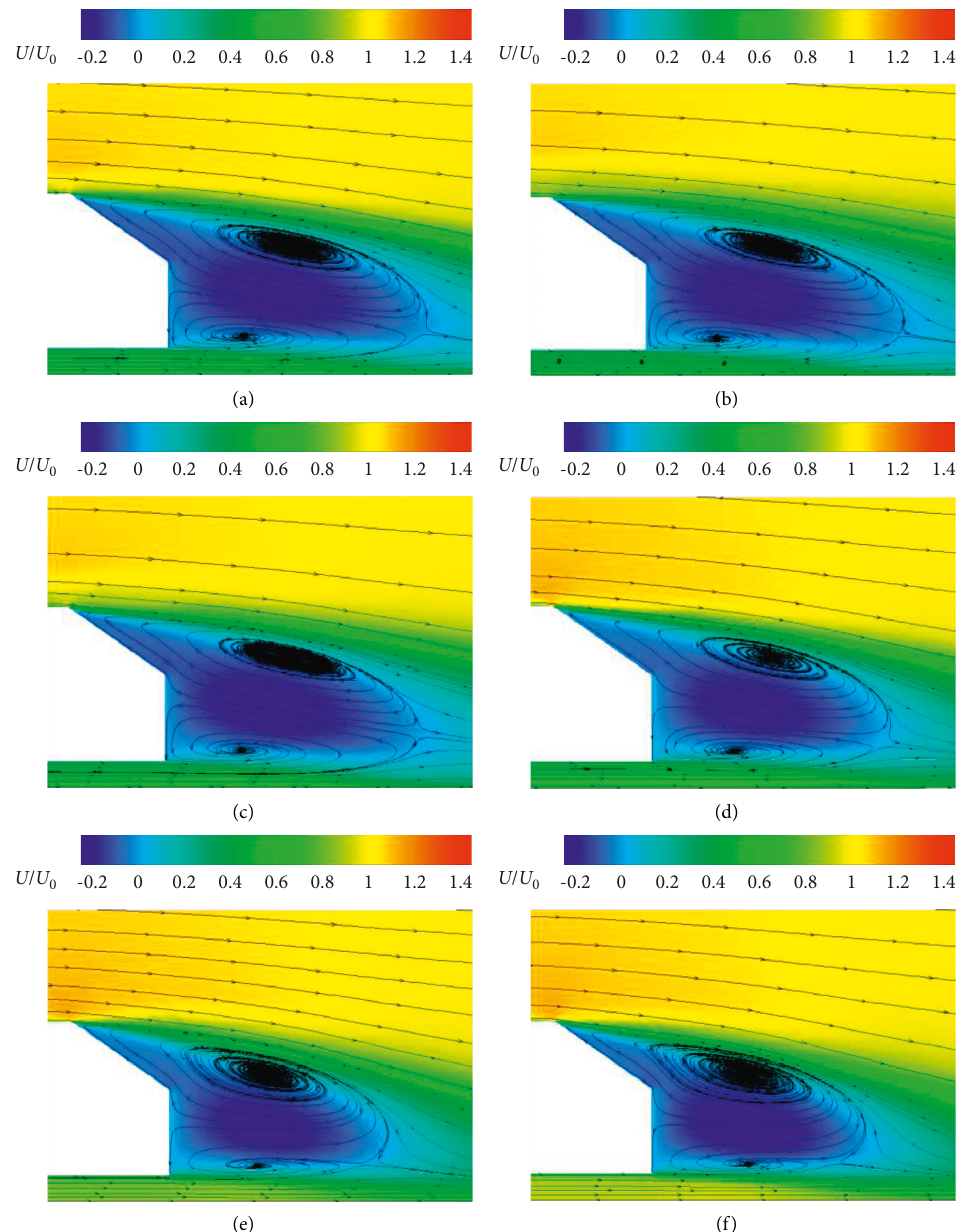
Figure 15: x -direction velocity contour and streamline distribution behind trailing body in three bodies on xz symmetry plane. (a) x/L � 0.25 (b) x/L � 0.5. (c) x/L � 0.75. (d) x/L � 1. (e) x/L � 1.25. (f) x/L �